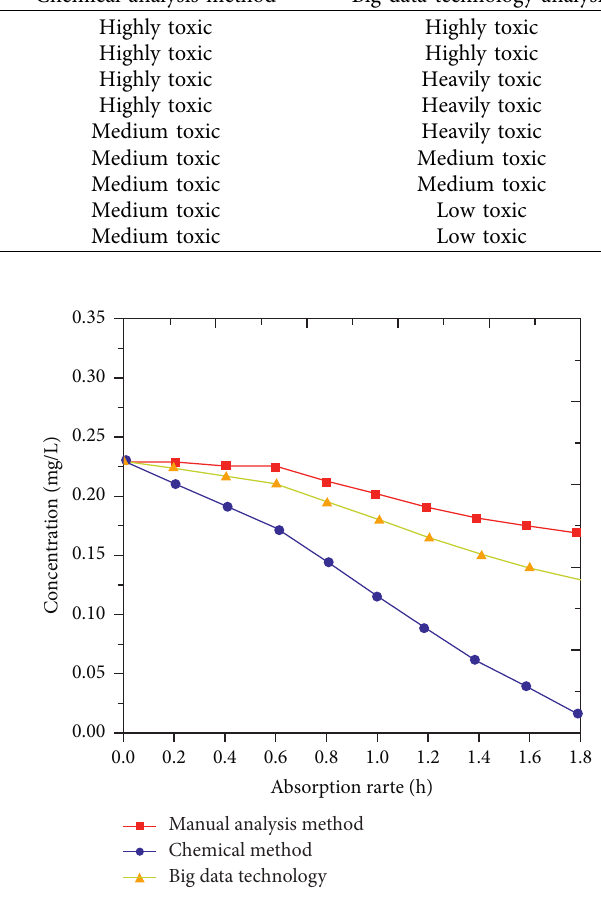
Figure 9: Different analysis methods to verify the pollution level of molecular